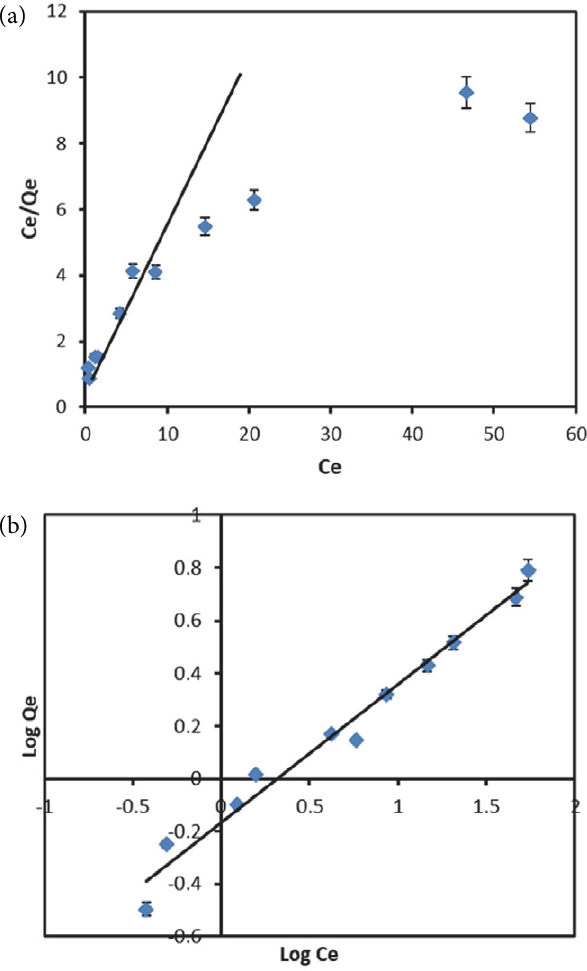
Figure 8. a The Langmuir adsorption isotherm and b The Freun- dlich adsorption isotherm for the results shown in Figure